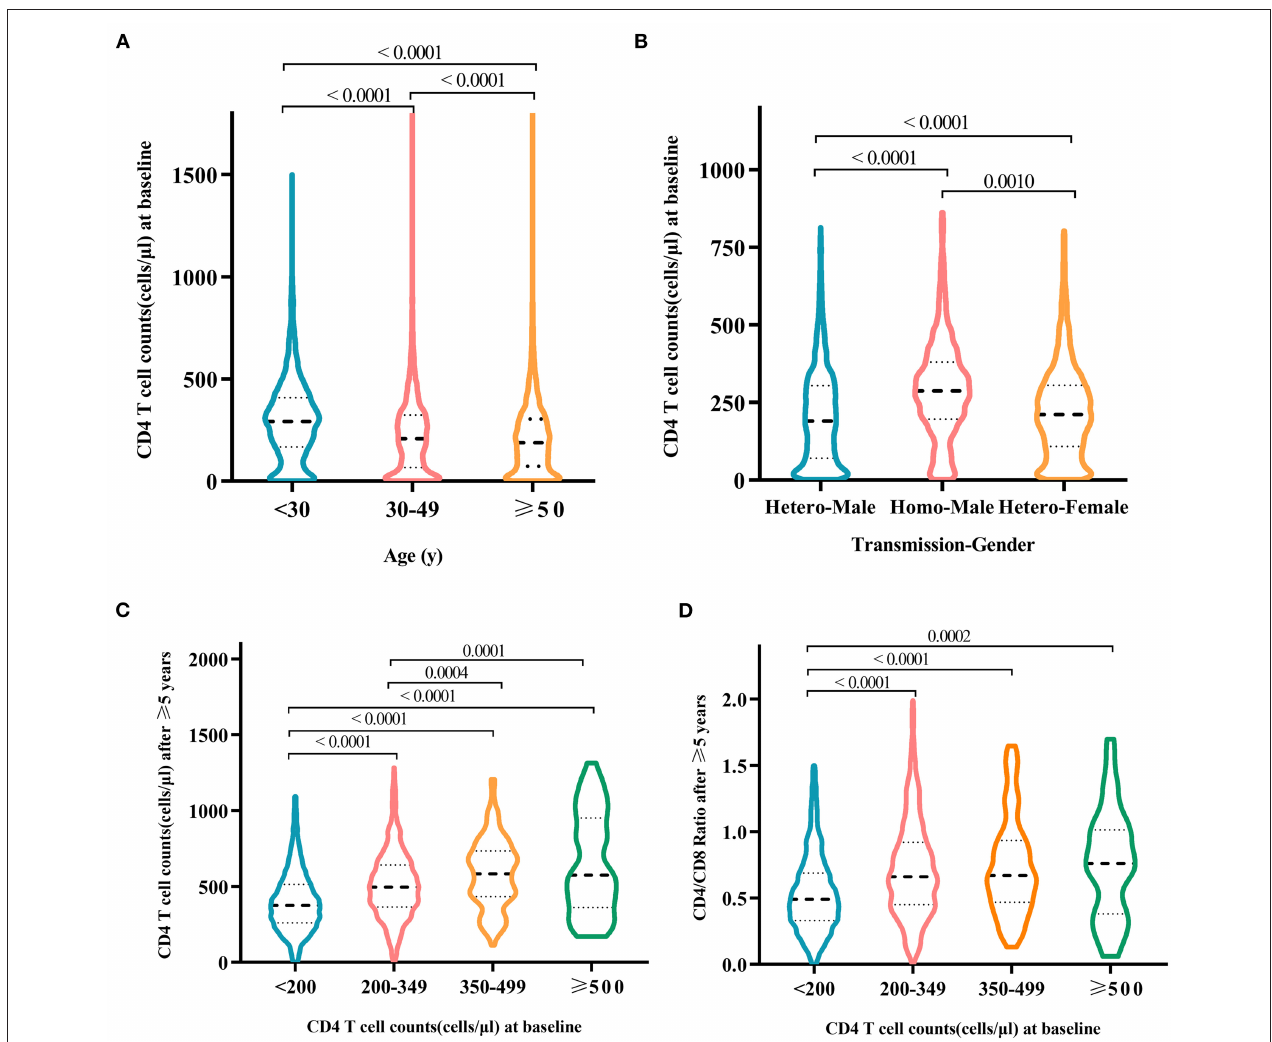
FIGURE 5 | Differences in baseline CD4 + T-cell counts among HIV-infected patients at different ages (A) and patients of different genders infected by different transmission routes (B) . After treatment for more than 5 years, patients with different baseline CD4 counts were diagnosed with the follow-up of CD4 counts (C) and CD4/CD8 ratio (D) . Only statistically significant groups were labeled.